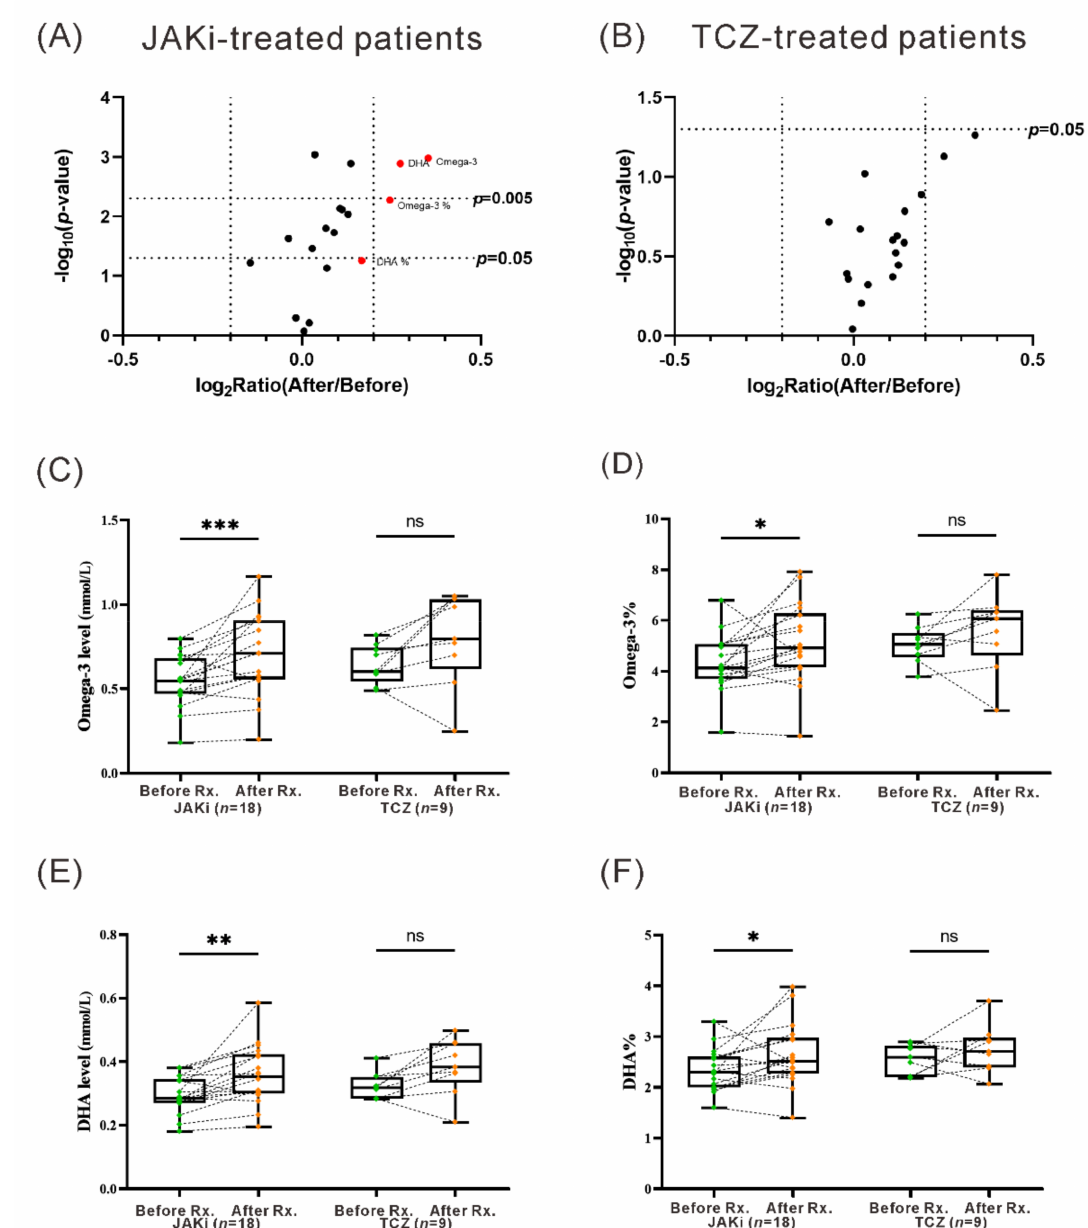
Figure 2. The change in serum levels of lipid metabolites determined by the 1 H NMR-based lipid/metabolomics in patients treated for six months with JAKi or TCZ. The volcano plot of fatty acids levels changes in ( A ) JAKi-treated or ( B ) TCZ-treated patients. The comparison of serum levels of ( C ) omega-3 level, ( D ) omega-3%, ( E ) DHA level, and ( F ) DHA% before and after treatment with JAKi or TCZ. Rx.: treatment. Data in Figure 2C–F are presented as box-plot diagrams, with the box encompassing the 25th percentile (lower bar) to the 75th percentile (upper bar). The horizontal line within the box indicates median value respectively for each group. * p < 0.05, ** p < 0.005, *** p < 0.001, was determined by the Wilcoxon signed rank test. JAKi: Janus kinase inhibitors; TCZ: tocilizumab; PUFAs: polyunsaturated fatty acids; DHA: docosahexaenoic acid; ns: no